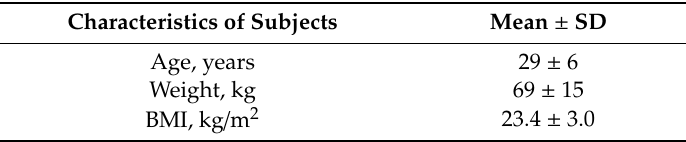
Table 1. Characteristics of study participants ( n = 10).